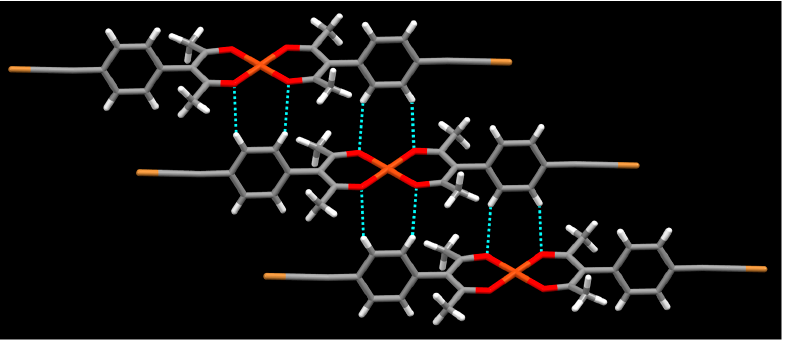
Figure 11. Intermolecular hydrogen bonds in the crystal structure of [Cu( L2) 2 ]·2CH 3 NO 2 (solvent molecules are omitted, color codes: red—oxygen; gold—bromine; orange—copper).